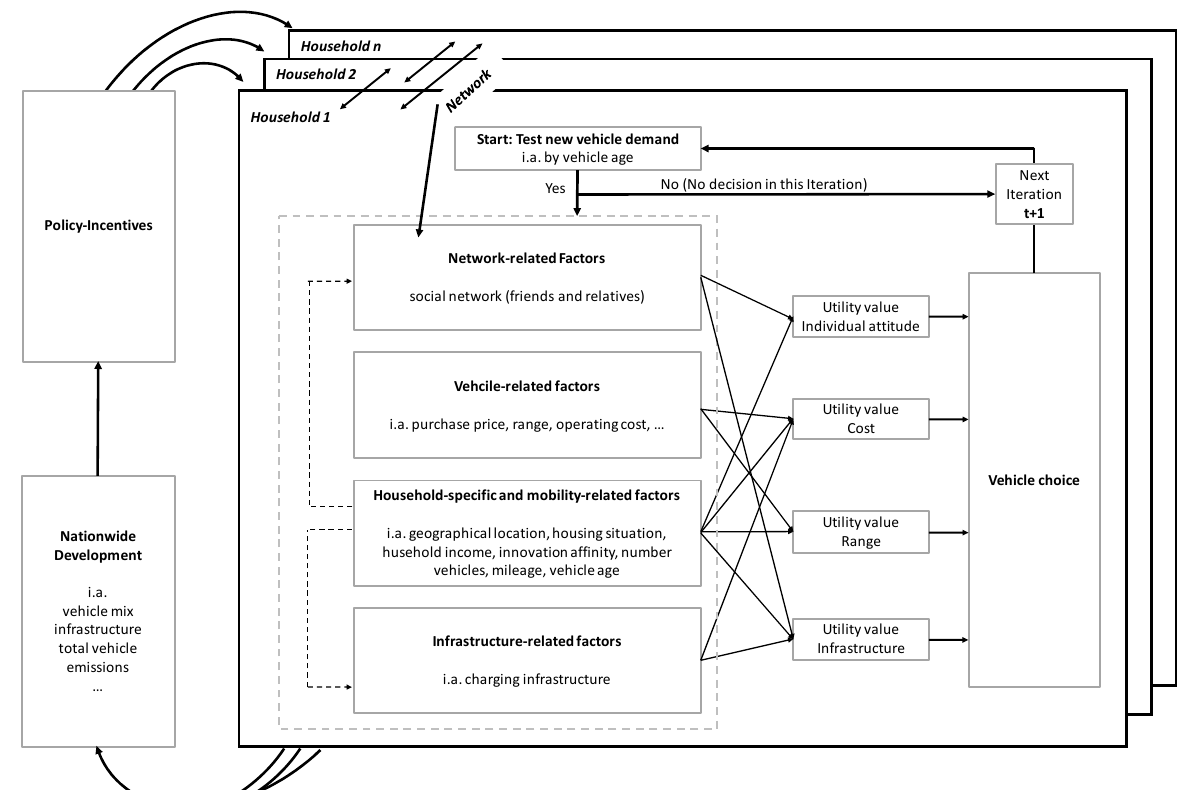
Figure 3. Schematic representation of the agent-based model (simplified) (own illustration).